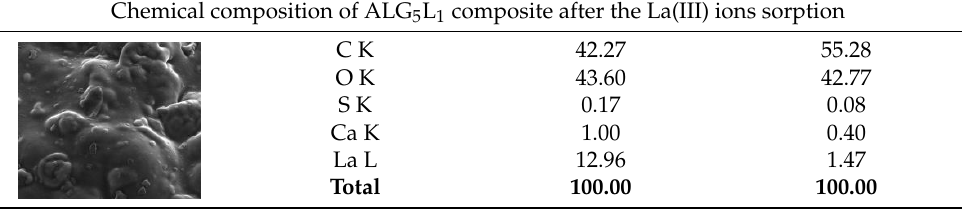
Figure 7. Nonlinear fitting of the isotherm models for ( a ) La(III), ( b ) Ce(III), ( c ) Pr(III), and ( d ) Nd(III) ions sorption on the ALG 5 L 1 composite at 333 K (conditions: C 0 = 25 – 500 mg/dm 3 , pH = 5, V = 20 cm 3 , m = 0.05 g, t = 1440 min).